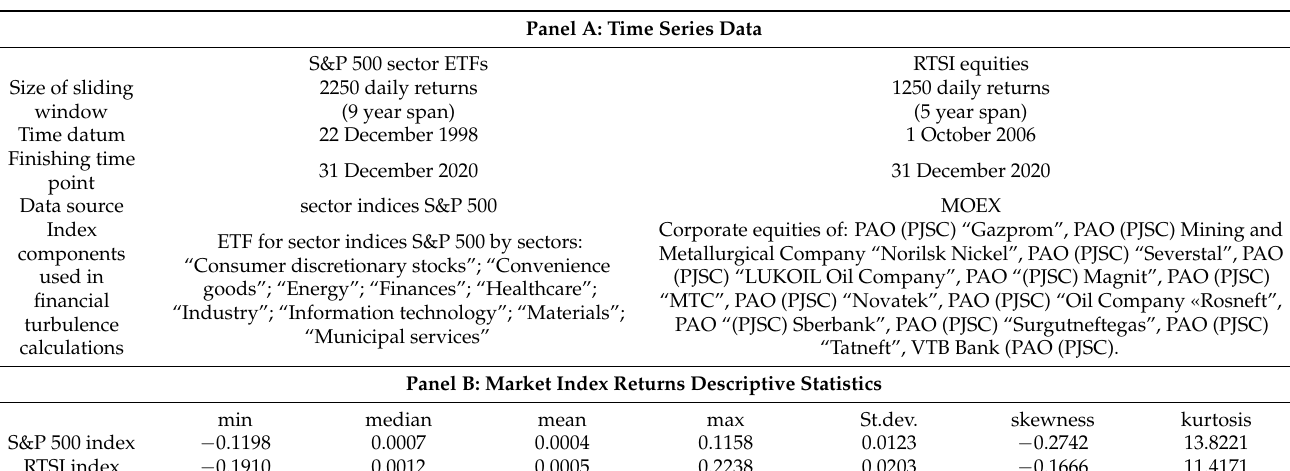
Table 1. Description of source